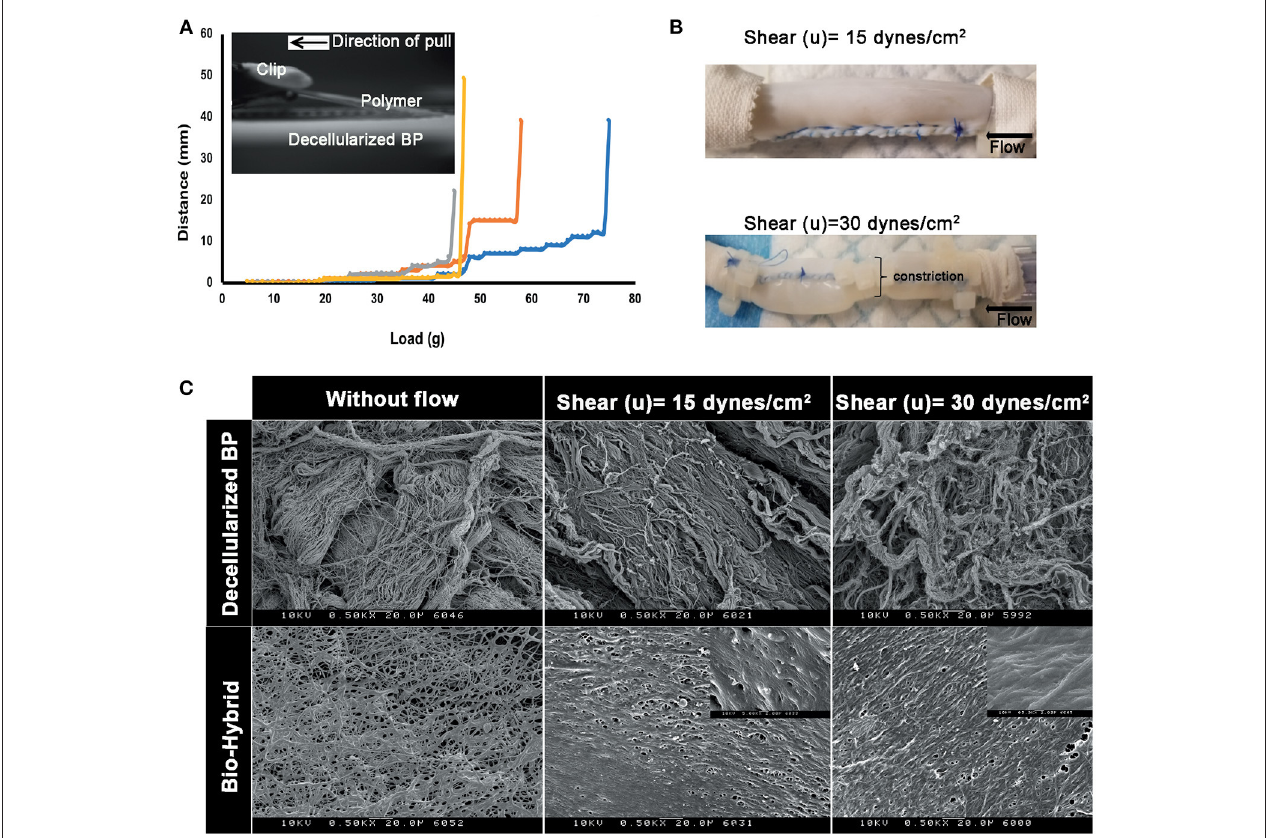
FIGURE 4 | Peel strength of the polymer in the biohybrid. (A) Peel profile of the biohybrid composite showing the load measured to peel the polymer in the biohybrid from the decellularized BP by using a customized setup where the polymer was peeled by using a clip attached to a weight hanger and a pulley, (B) image of the biohybrid composite conduit subjected to low shear and high shear (a portion of sample constricted to about 50% of original diameter) experienced by a normal artery (15 dynes/cm 2 ) in a continuous flow loop, and (C) SEM images of the decellularized BP samples subjected without any shear (without flow), low (15 dynes/cm 2 ) and high shears (30 dynes/cm 2 ) showing extent of damage of the extracellular matrix fibers due to the shear. SEM images of the biohybrid samples subjected without any shear (without flow), low and high shears showing non-delamination and smoothening of the polymer surface when subjected to